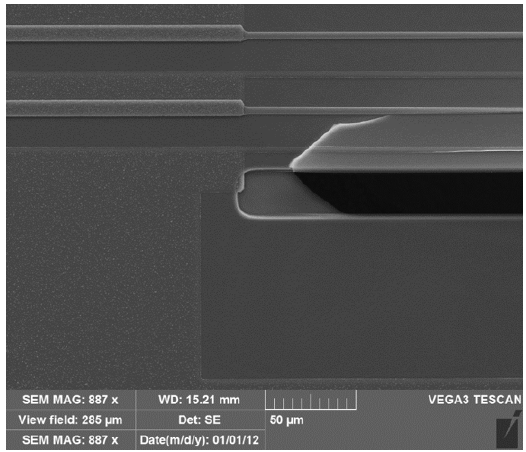
Fig. 8 SEM image of a failed double-ended symmetrical square thermopile structure with adiabatic grooves, with a broken diaphragm near the cold end.